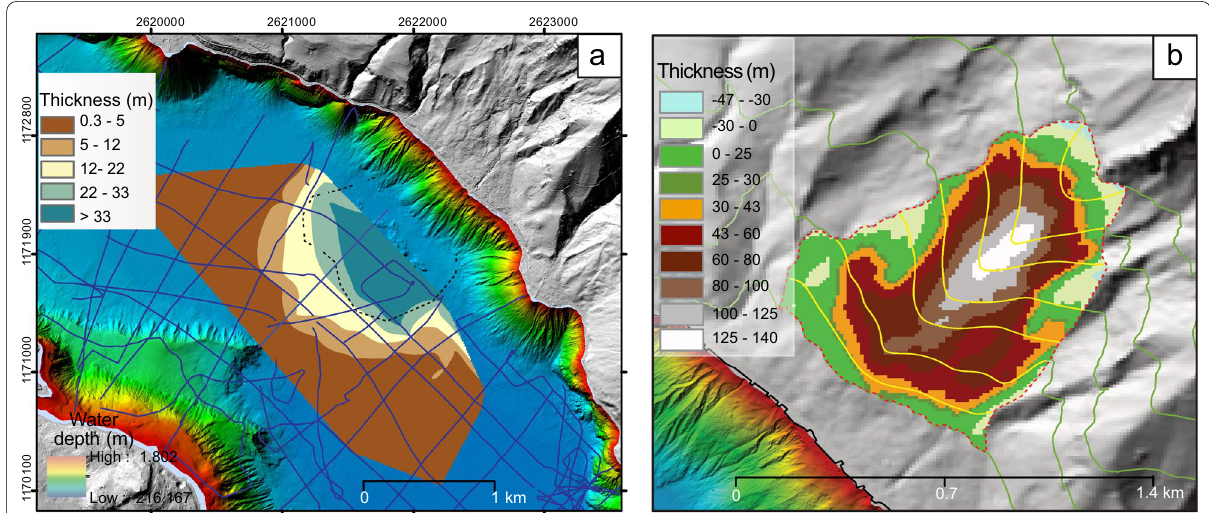
Fig. 6 Off- and on-shore thickness maps. a Off-shore thickness map of the seismic facies related to the rockslide-induced deposit (with basin plain sediments). The limits of the amphitheatre structure are shown with a black dashed line. b On-shore thickness map of the potentially terrestrial failed mass as the difference between the present and reconstructed topography. Negative thickness values are due to extrapolation uncertainties. Source of the digital elevation model: Swisstopo, Federal Office of